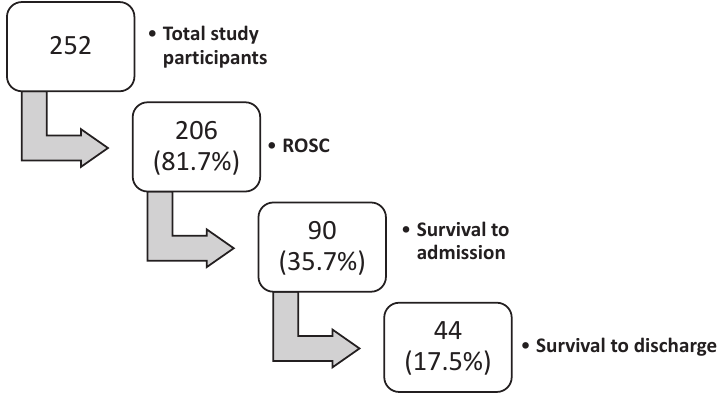
Figure 2. Survival to discharge rate following In-hospital cardiac arrest.